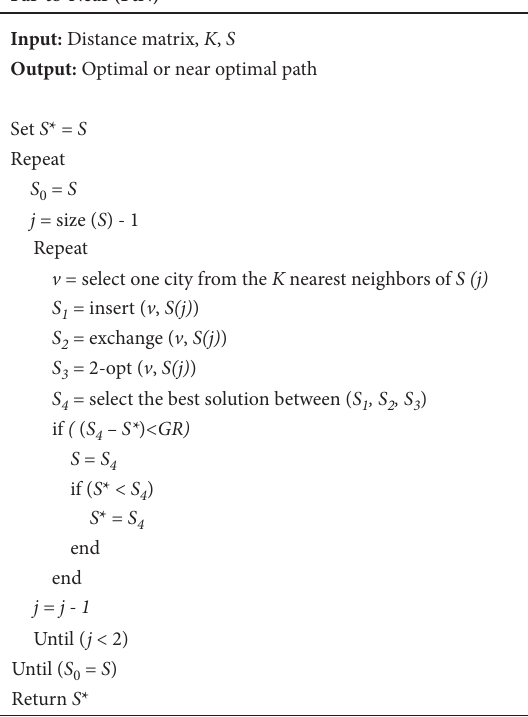
Figure 10: The general body of the proposed local search metaheuristic